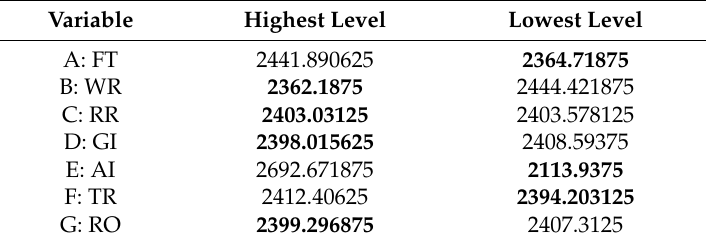
Table 11. Summary of the discomfort hours registered at each of the two levels of the seven